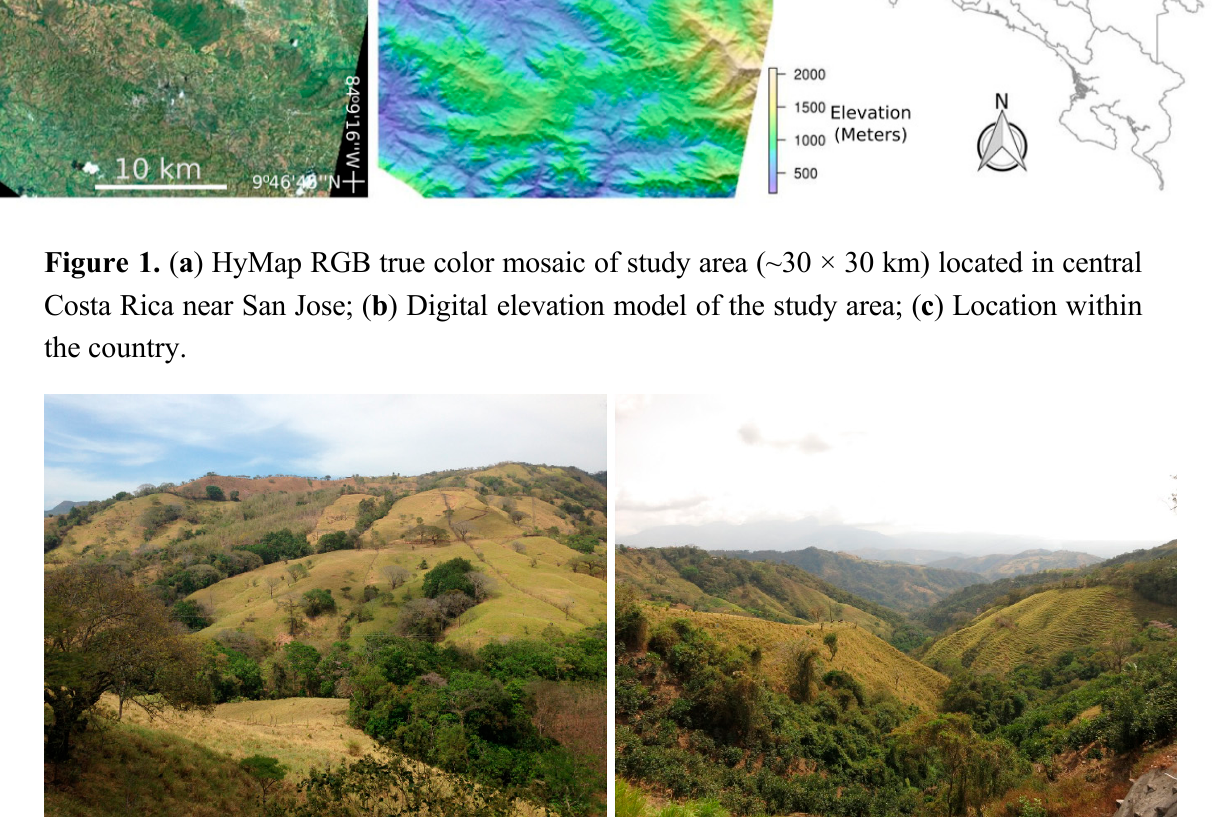
Figure 2. Examples of the terrain characteristics of the study area which include extensive coffee plantations and grazing areas in rugged mountainous